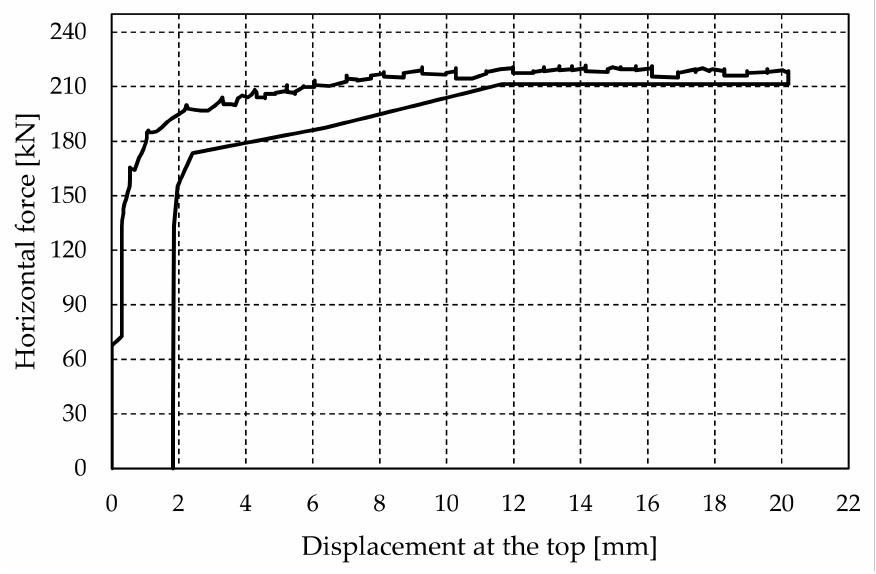
Figure 22. Pushover curve for W4 (V = 460 kN, σ v = 0.8 N/mm 2 ). Assuming that the walls are rigid, Equation (9) yields H = 230 kN, which is approxi- mately equal to the measured decompression force. Resistance and deformability parame- ters of the strengthened walls W3 and W4 for precompression level of σ v = 0.8 N/mm 2 are presented in Table 9. The results of bilinear idealization of hysteretic curves are listed in Table 10. Energy dissipation is shown through the equivalent viscous damping coefficient in Table